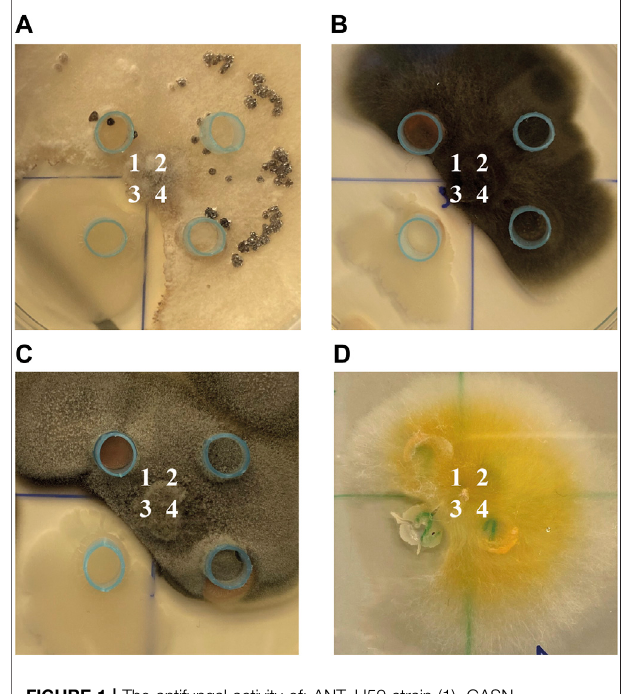
FIGURE 1 | The antifungal activity of: ANT_H59 strain (1), GASN medium, as control (2), ANT_WA51 strain (3) and ANT_H12B strain (4) against: (A) B. cinerea WA72082, (B) Alternaria sp. WA67128, (C) Cladosporium sp. WA72809 and (D) F. tricinctum